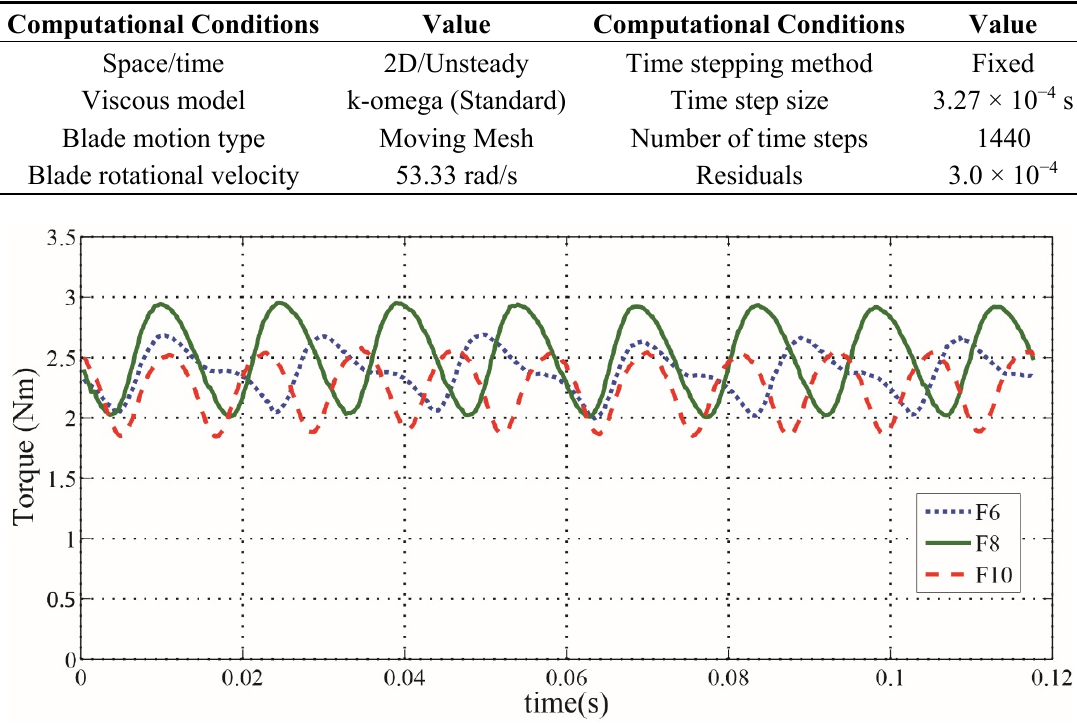
Table 2. CFD simulation conditions for the rotor analyses.